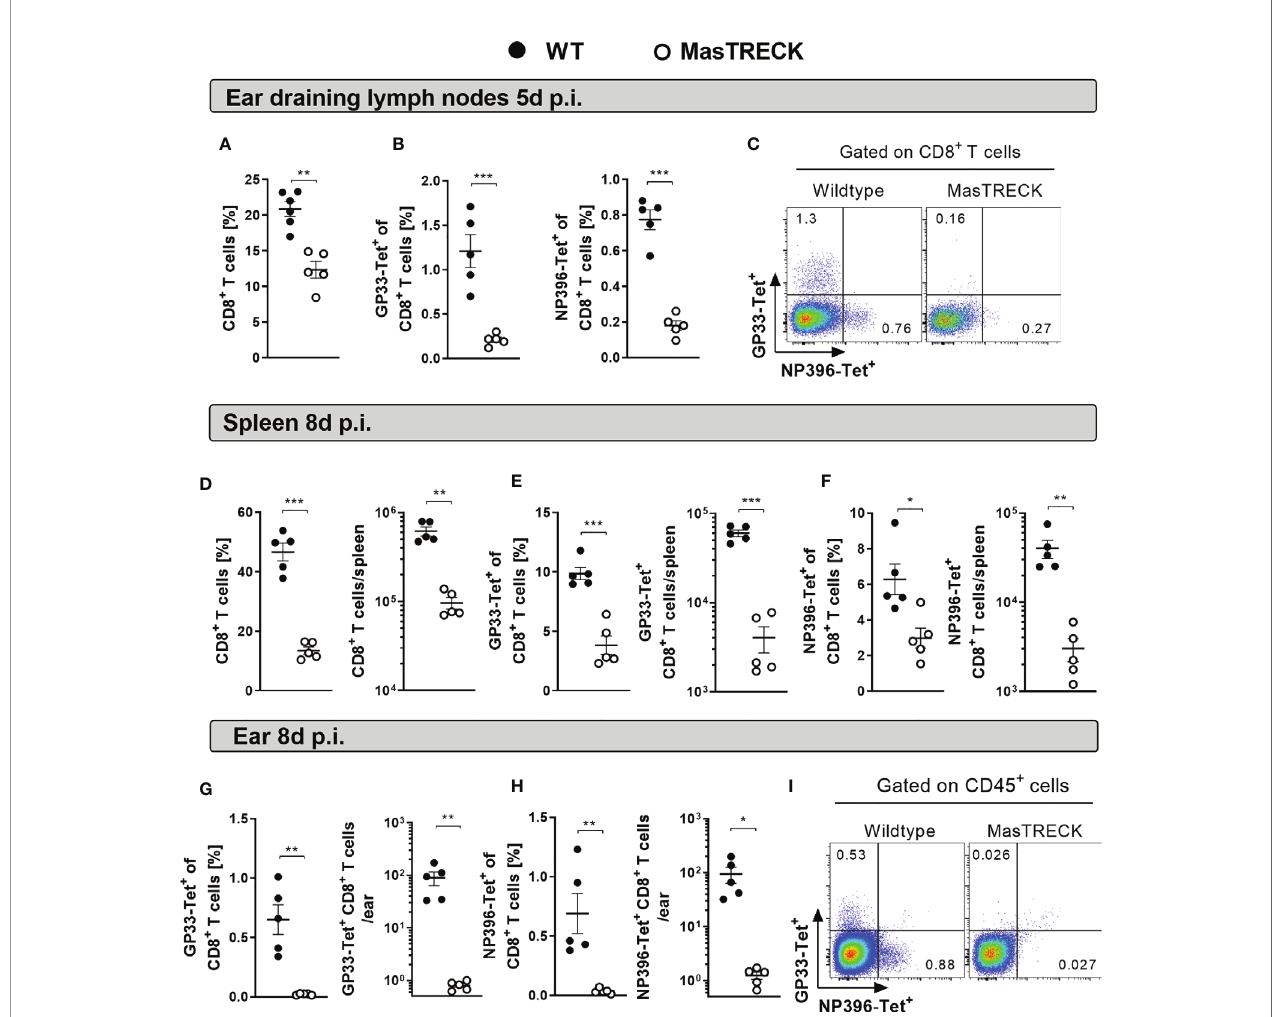
FIGURE 2 | Mast cells are key players in the expansion and recruitment of virus-speci fi c CD8 + T cells. (A) Frequencies of CD8 + T cells, (B) GP33-Tetramer + and NP396-Tetramer + CD8 + T cells in the ear-dLN as well as (C) representative FACS plots from WT and MasTRECK mice at day 5 post intradermal LCMV infection. Frequencies and absolute numbers of (D) CD8 + T cells, (E) GP33-Tet + and (F) NP396-Tet + CD8 + T cells in the spleen of WT and MasTRECK mice at day 8 post LCMV infection. Frequencies and absolute numbers of (G) GP33-Tet + and (H) NP396-Tet + cells in the ear of WT and MasTRECK mice as well as (I) representative FACS plots at day 8 post LCMV infection analyzed by fl ow cytometry. All experiments were performed at least twice, and each experimental group included n ≥ 4. Data are representative and expressed as mean ± SEM. Statistically signi fi cant differences are analyzed by t- test and indicated as follows: *p < 0.05, **p < 0.01, ***p <